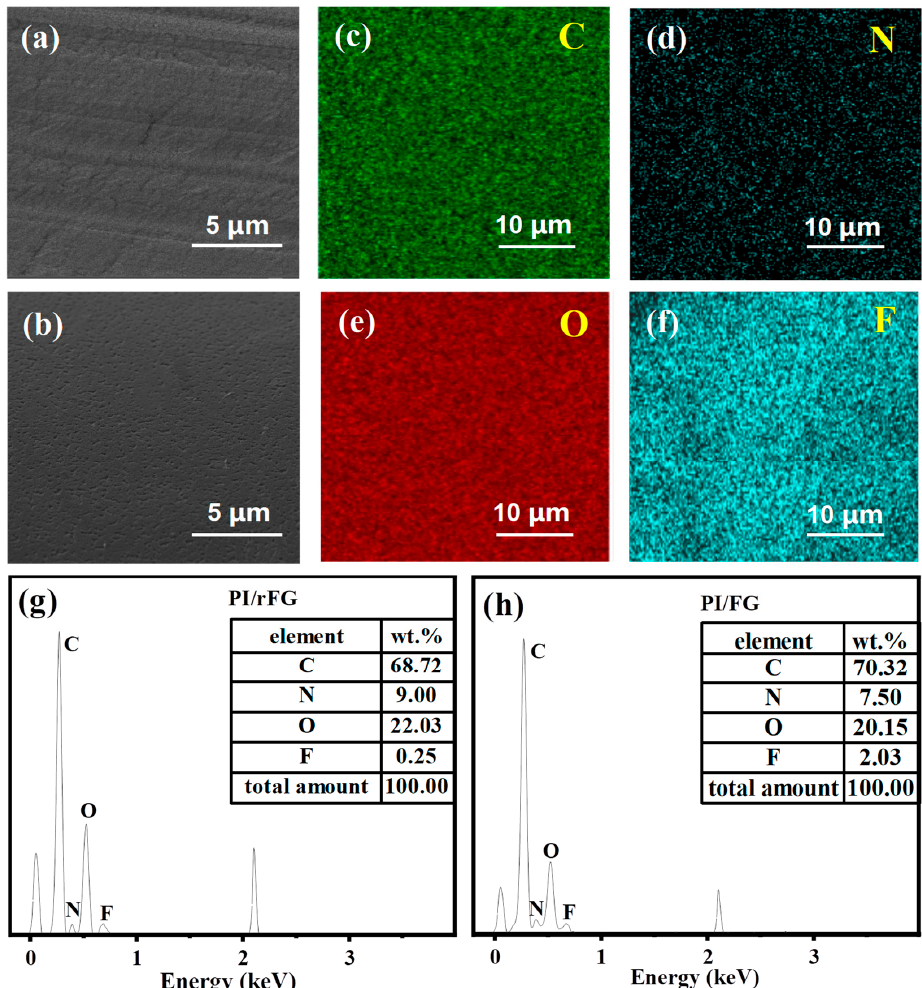
Figure 1. The characterization of PI composite films. ( a ) SEM image of the interface of the PI films; ( b ) SEM image of the interface of the PI/rFG-8 wt. % composite films; ( c – f ) element mappings of the PI/rFG-8% composite films; ( g ) the EDS of the PI/rFG-8% composite films; ( h ) the EDS of the PI/FG composite films with 8 wt. % FG of added without PEG.